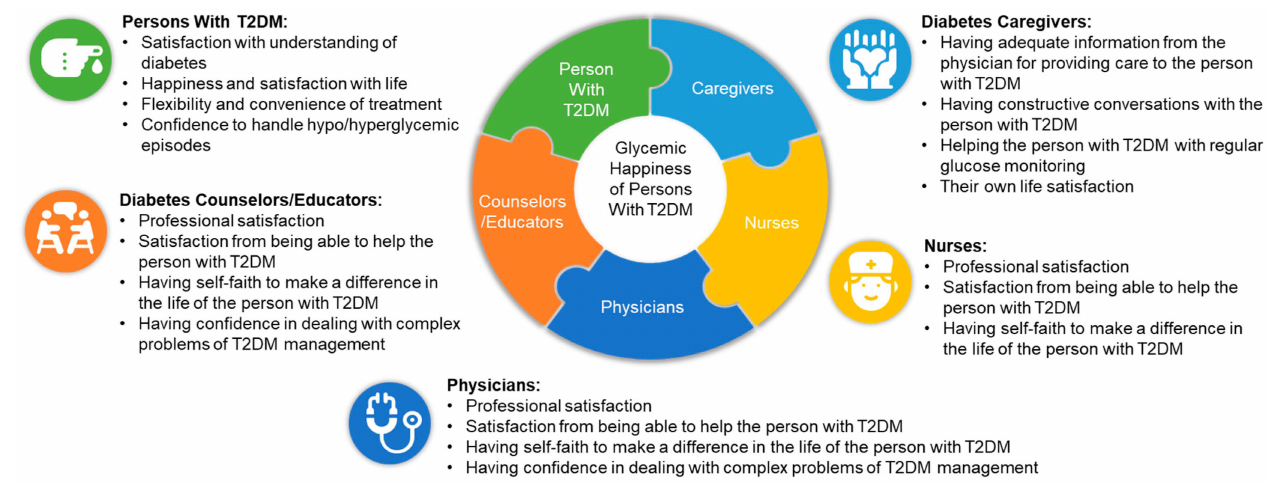
Figure 1. Patient, caregiver, nurse, physician, and diabetes counselor/educator-related factors affecting the glycemic happiness of persons with T2DM: Summary of findings from the survey. T2DM: Type 2 diabetes